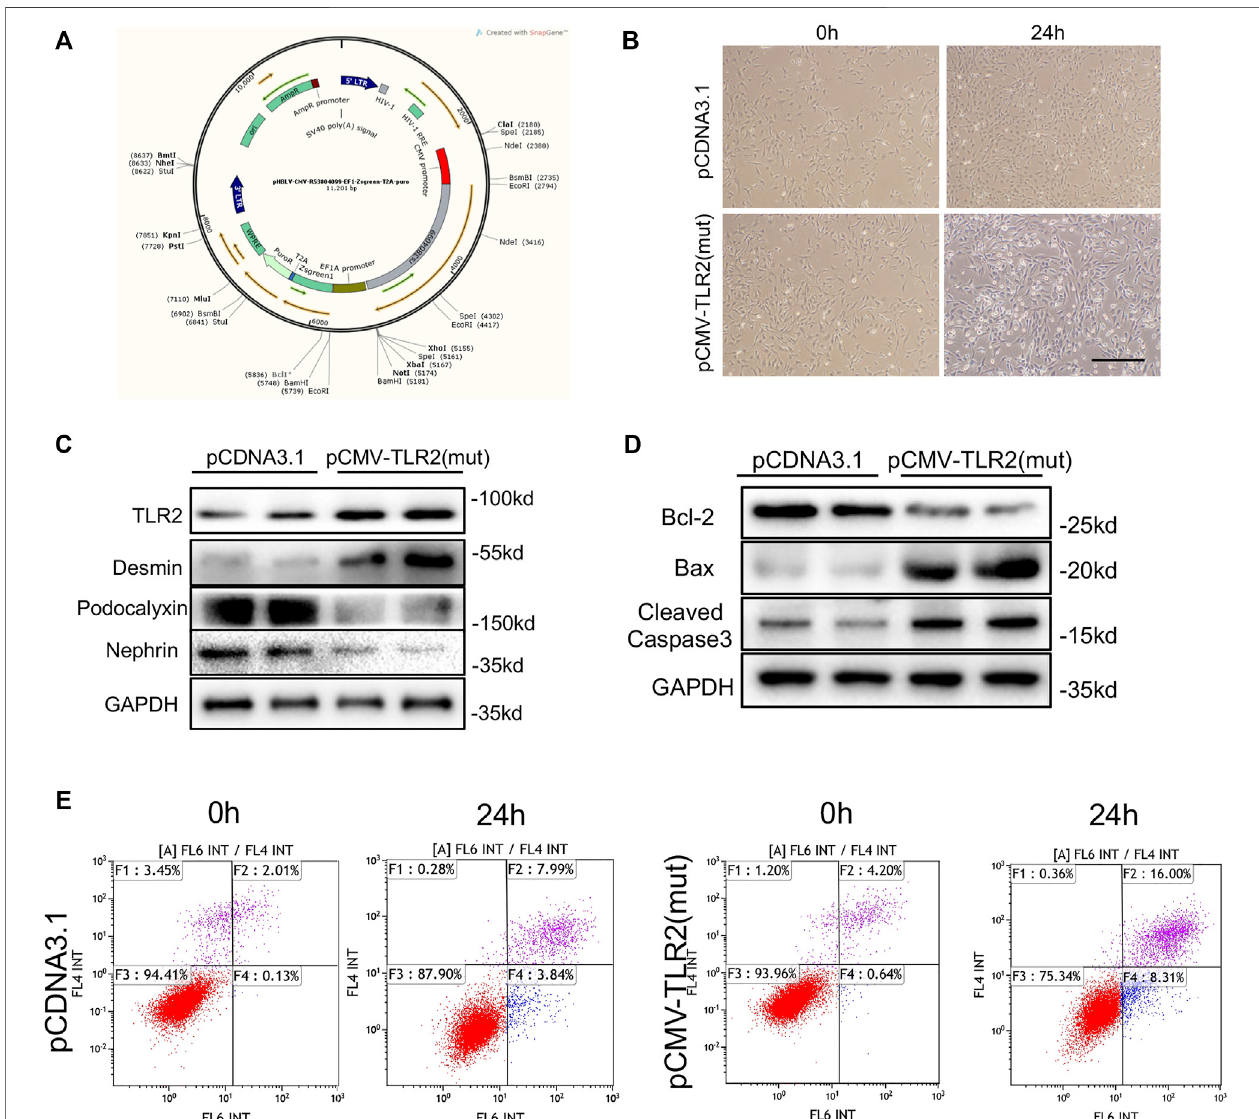
FIGURE 3 | Rs3804099 mutation on the TLR2 gene contributed to cell injury and apoptosis in podocytes. (A) Wild-type (pCDNA3.1) and mutated (pCMV-TLR2) plasmidsofrs3804099wereconstructedforfurtherveri fi cation. (B) Aftertransfectionfor24 h,podocytesinthemutantgroupshowedmassivemorphologicalalterations compared with the wild-type group. (C) Western blotting assays showed that mutant plasmids transfected in podocytes could signi fi cantly reduce podocalyxin and nephrin expression levels but enhance the expression level of desmin, coupled with the increased expression of TLR2. (D) The protein level of Bcl-2 was reduced and Bax and cleaved-caspase-3 expressions were increased in the mutant group compared with the wild-type group. (E) Flow cytometry results revealed that the cell apoptosis rate was remarkably increased in a time-dependent manner in the mutant group compared with the wild-type group.